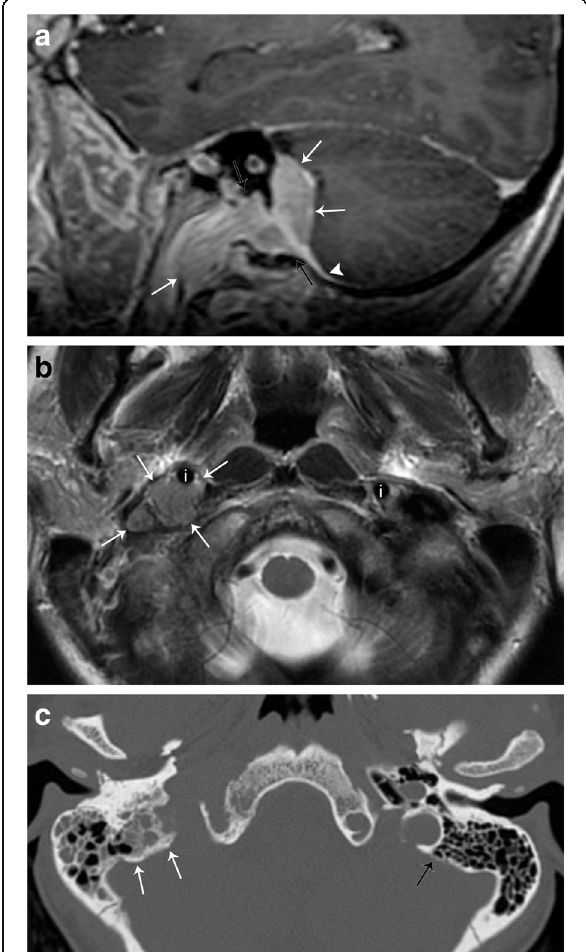
Fig. 10 Meningioma. a Sagittal T1-weighted post-contrast MR image demonstrates an enhancing mass (white arrows) extending from the posterior fossa through the jugular foramen (black arrows) into the right carotid space. An enhancing dural tail is seen (arrowhead). b Axial T2-weighted MR image demonstrates the mass to be intermediate in signal (white arrows), anteriorly displacing the internal carotid artery (i). The normal position of the left internal carotid artery is also seen. c Axial non-contrast CT image demonstrates hyperostosis of the bone adjacent to the known lesion (white arrows). Note the thickness of the normal left mastoid bone cortex (black